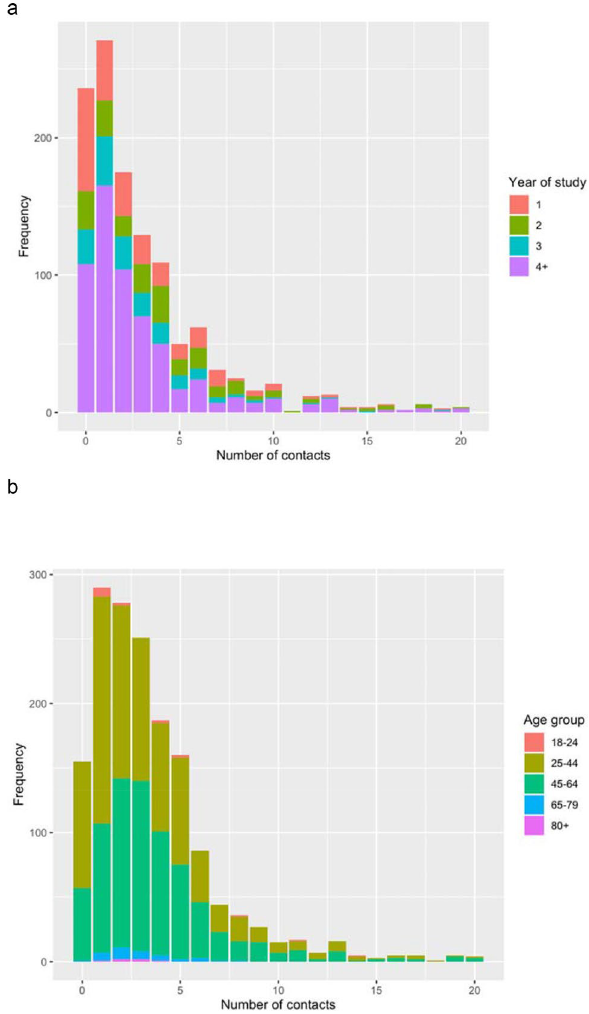
Figure 1. Unweighted histograms of the number of overall contacts* on the previous day among ( a ) students (including staff/students); ( b ) Staff (excluding staff/students). *81 students had more than 20 contacts on the previous day; 58 staff had more than 20 contacts on the previous day—full histograms are shown in Supplementary Figure 1.